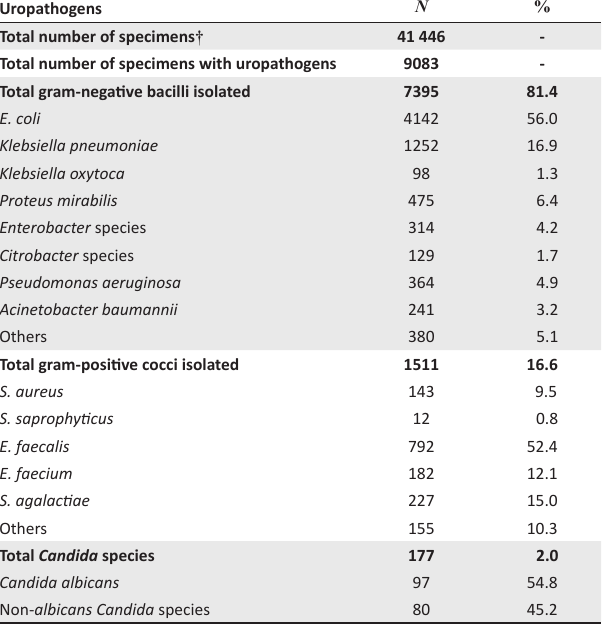
TABLE 1: Distribution of uropathogens isolates from Charlotte Maxeke Johannesburg Academic Hospital.